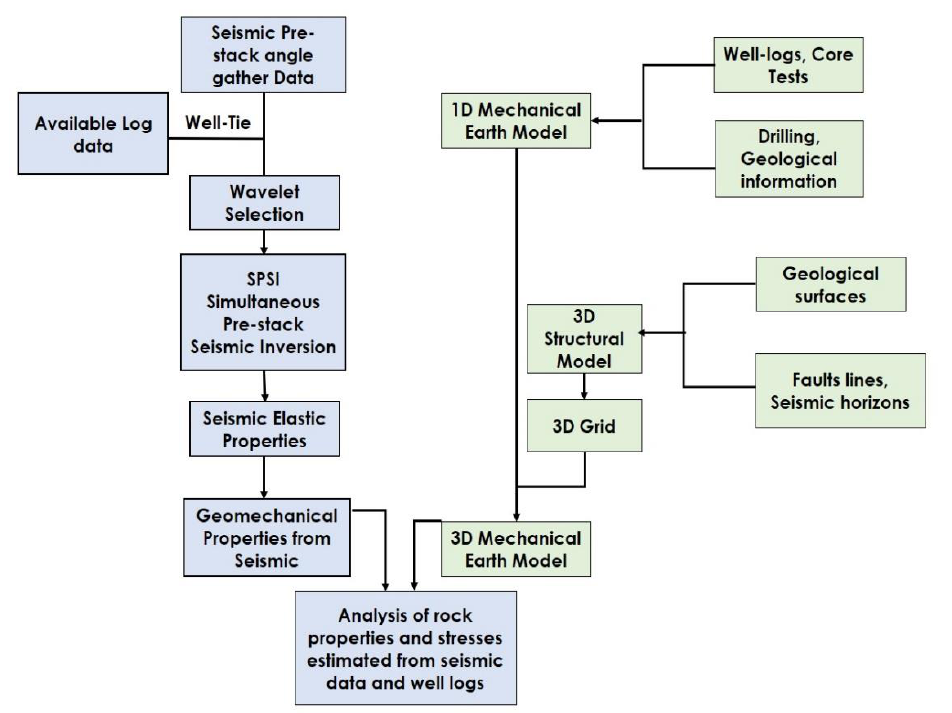
Figure 3. Workflow for the geomechanical properties estimation from seismic and well log